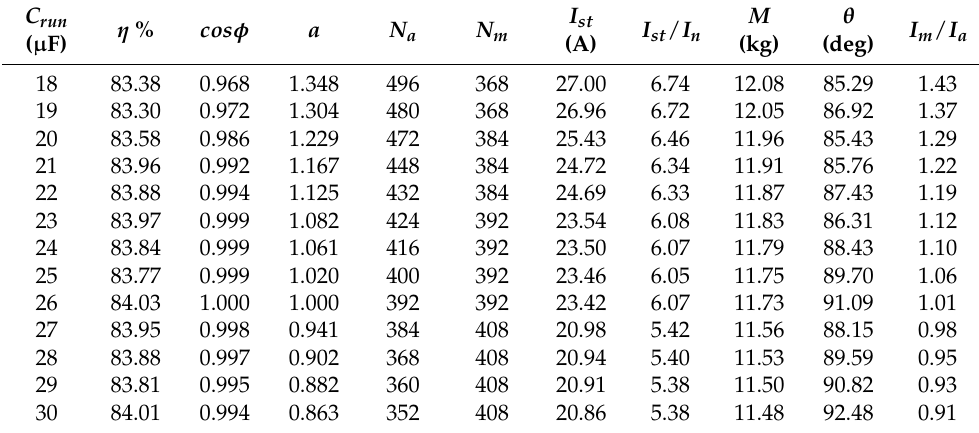
Table 7. Design parameters and performance quantities of the SPIMs with rotor bars of round shape.